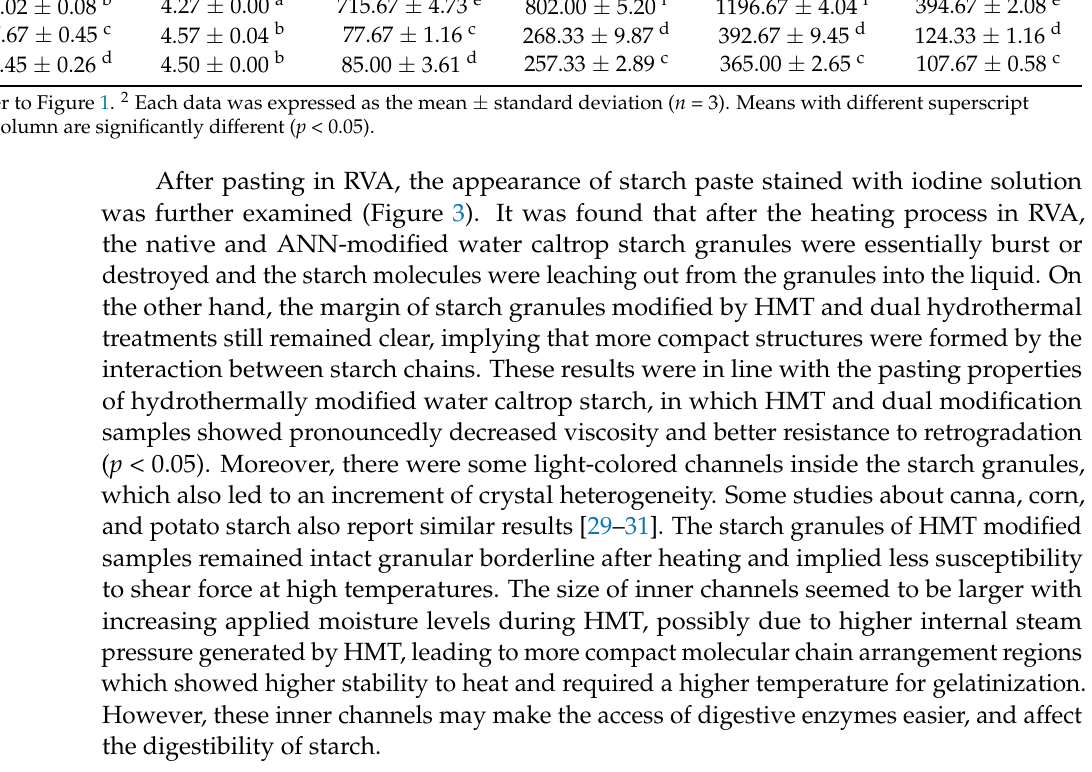
Table 1. Effect of various hydrothermal treatments on the pasting parameters of water caltrop starch 1,2 . Pasting Samples